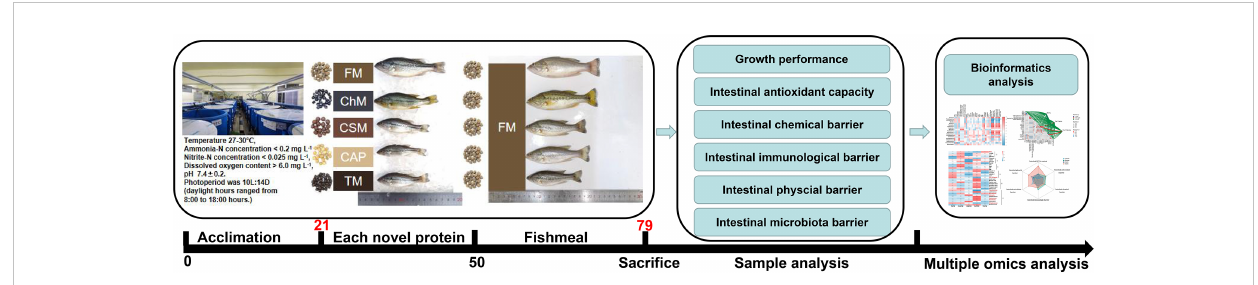
FIGURE 1 The work fl ow of this study. Whole fi shmeal diet, C. vulgaris diet, cottonseed protein concentrate, C. autoethanogenum diet, and T. molitor diet, referred as FM/FM, ChM/FM, CSM/FM, CAP/FM, and TM/FM,